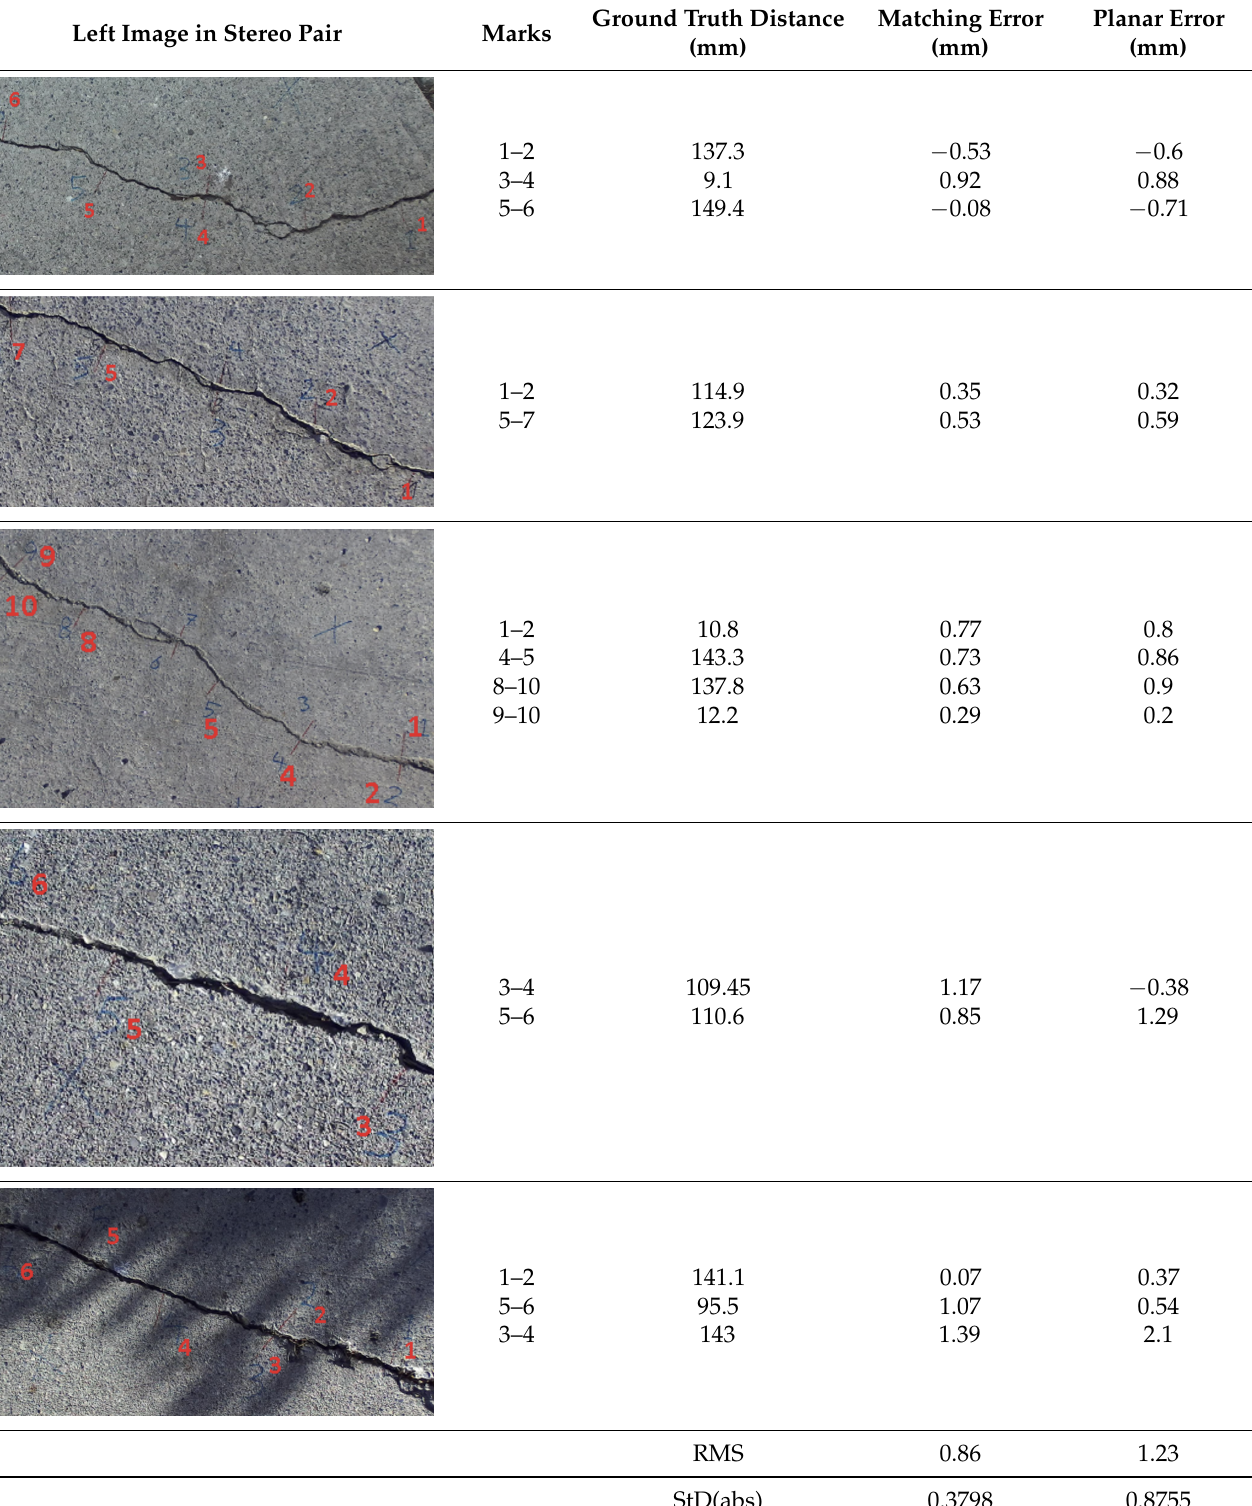
Left Image in Stereo Pair Marks